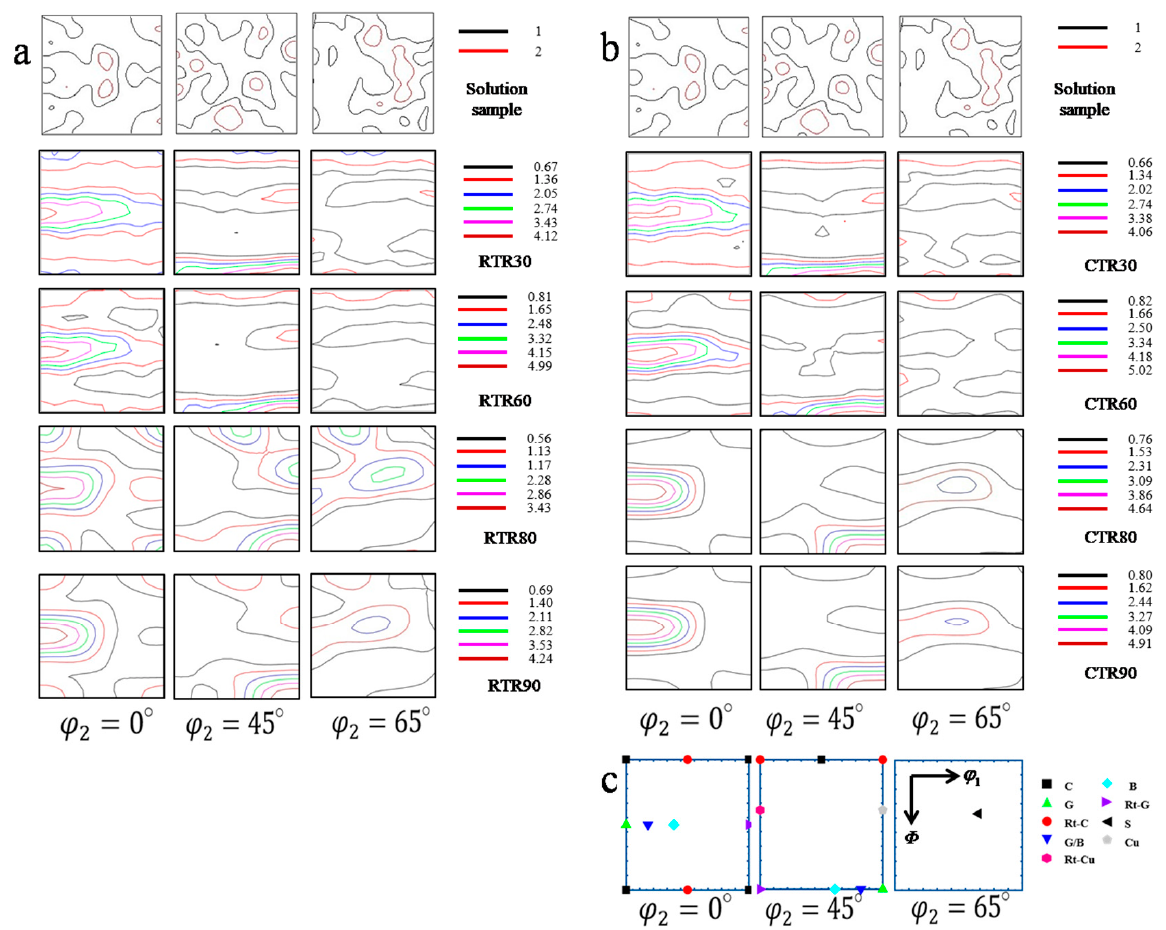
Figure 5. ODF plots of rolled samples at ( a ) room temperature and ( b ) cryogenic temperature; ( c ) schematic of the position of different texture components on the ODF section ( φ 2 = 0°, φ 2 = 45°, and φ 2 = 65°).